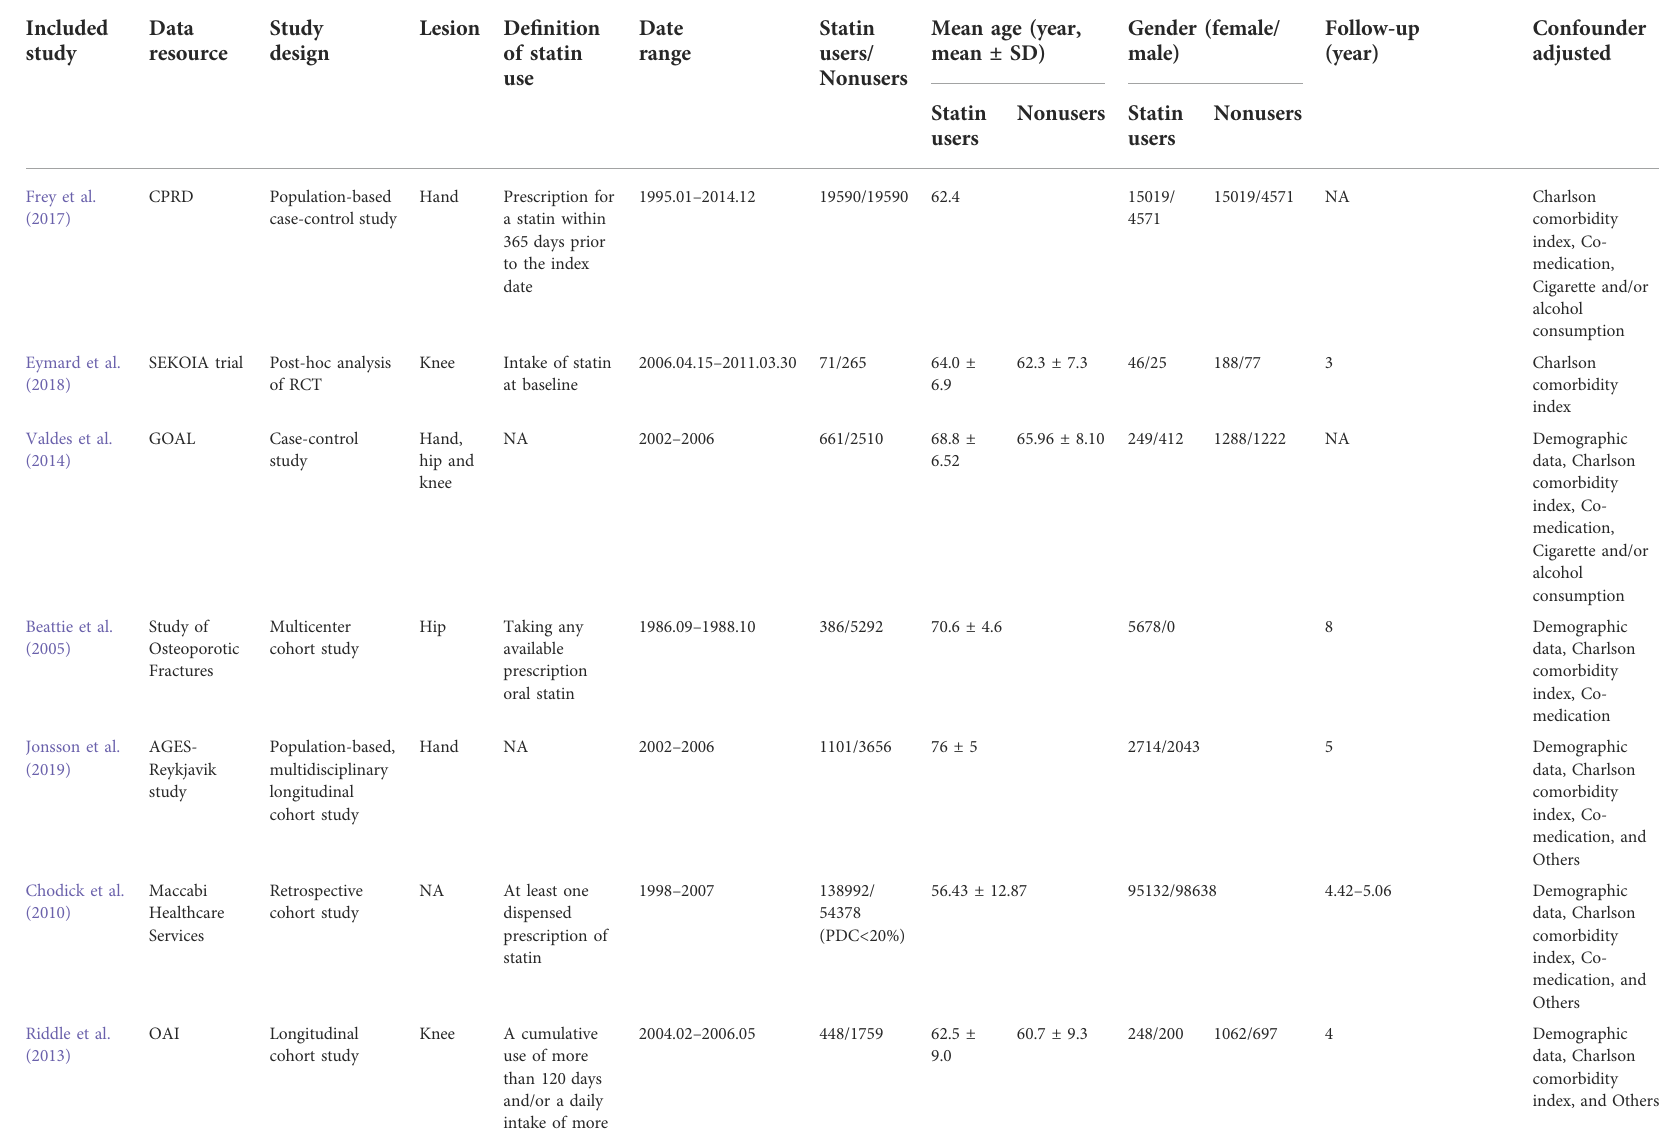
TABLE 1 Characteristics of included